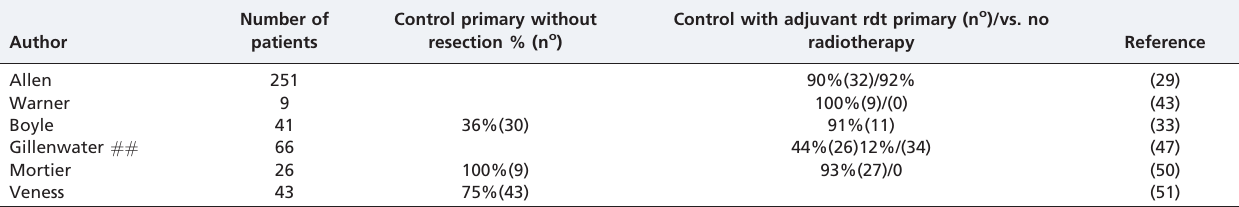
Table 3 - Radiotherapy: protocols and